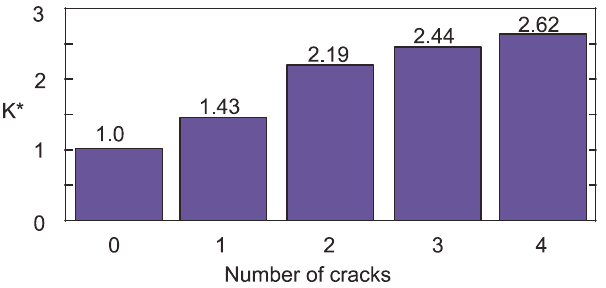
Figure 8: Criterion  *